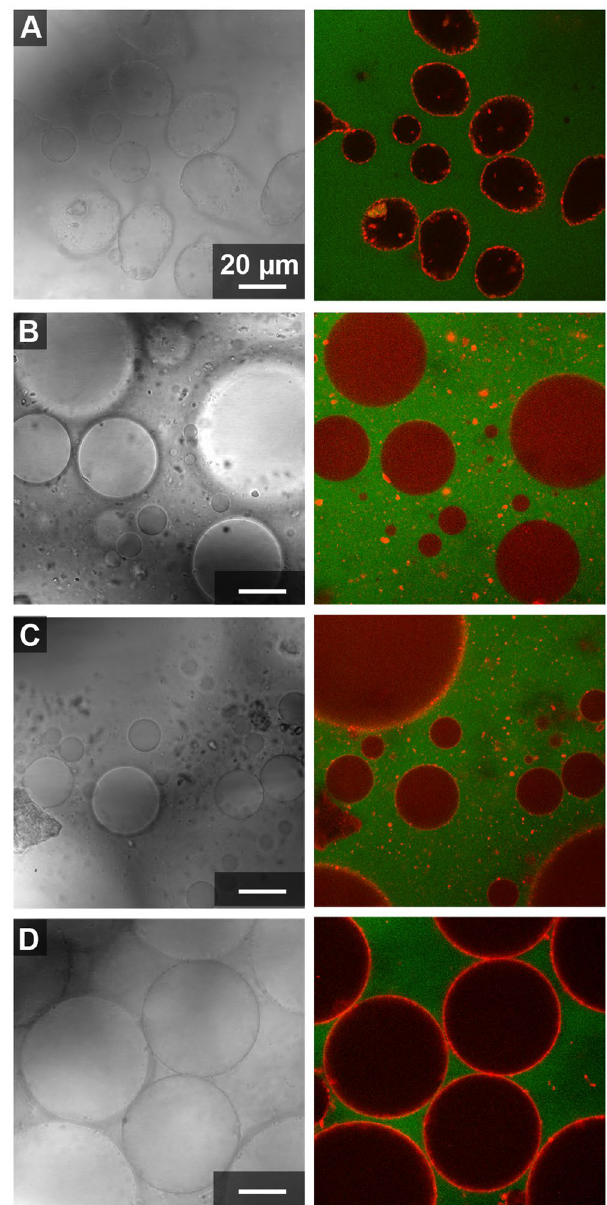
Figure 2. Confocal optical microscope images of clay particles with 1:1 volume ratio from 15%/15% w/w stock PEG-Dx ATPS. Fluorescent-labeled Dx (red) and PEG (green) have been used to image Dx-rich phase droplets and continuous PEG-rich phase. Clay particles appear red in fluorescence images due to adsorption of fluorescently labeled Dx to particle surface. Right images show overlay of fluorescence channels and left images show transmitted light for samples containing: ( A ) Kaolinite, ( B ) Na-rich montmorillonite, ( C ) Ca-rich montmorillonite and ( D ) illite in PEG-Dx